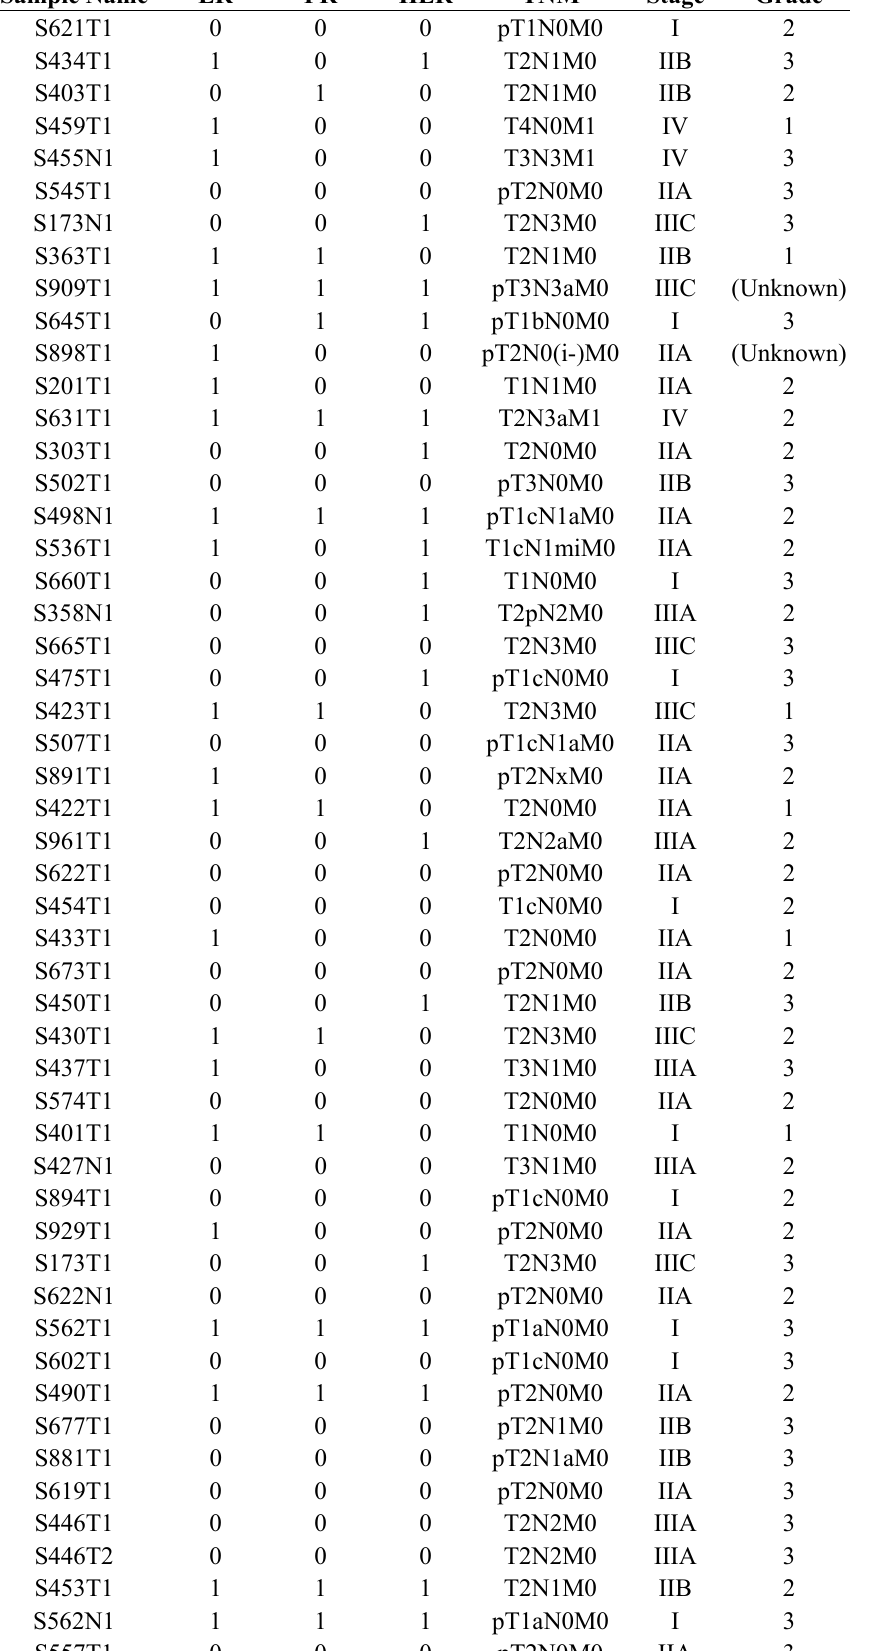
Table S8. Pathophysiogical characteristics of miRNA array data used in ROC curve